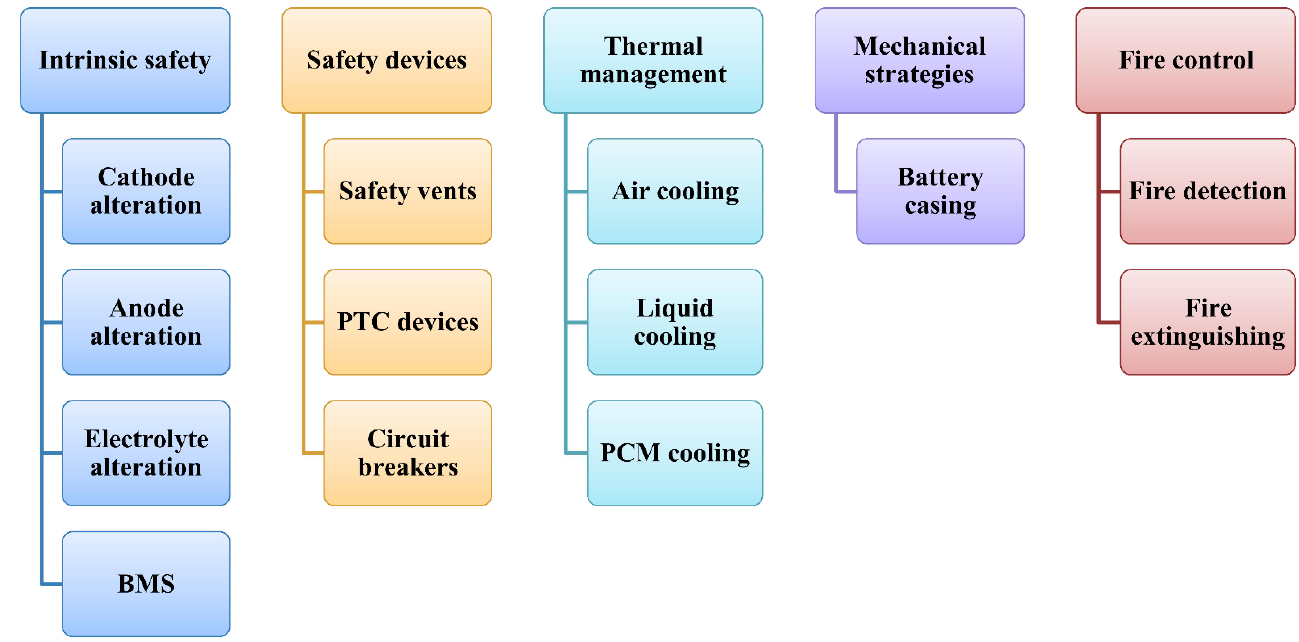
Figure 13. Classification of the main mitigation strategies implemented to achieve safety in Lithium-ion batteries.